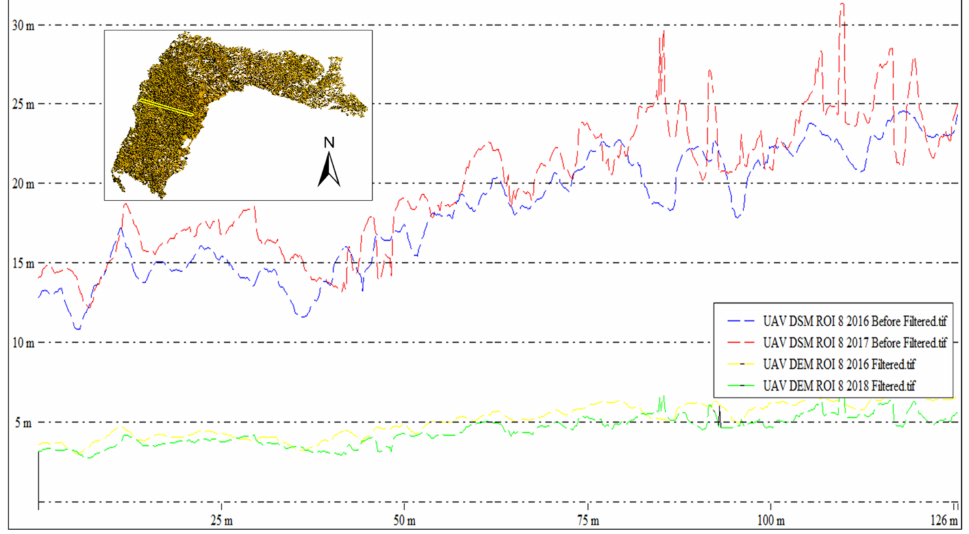
Figure A14. Average height comparison between filtered and unfiltered for ROI